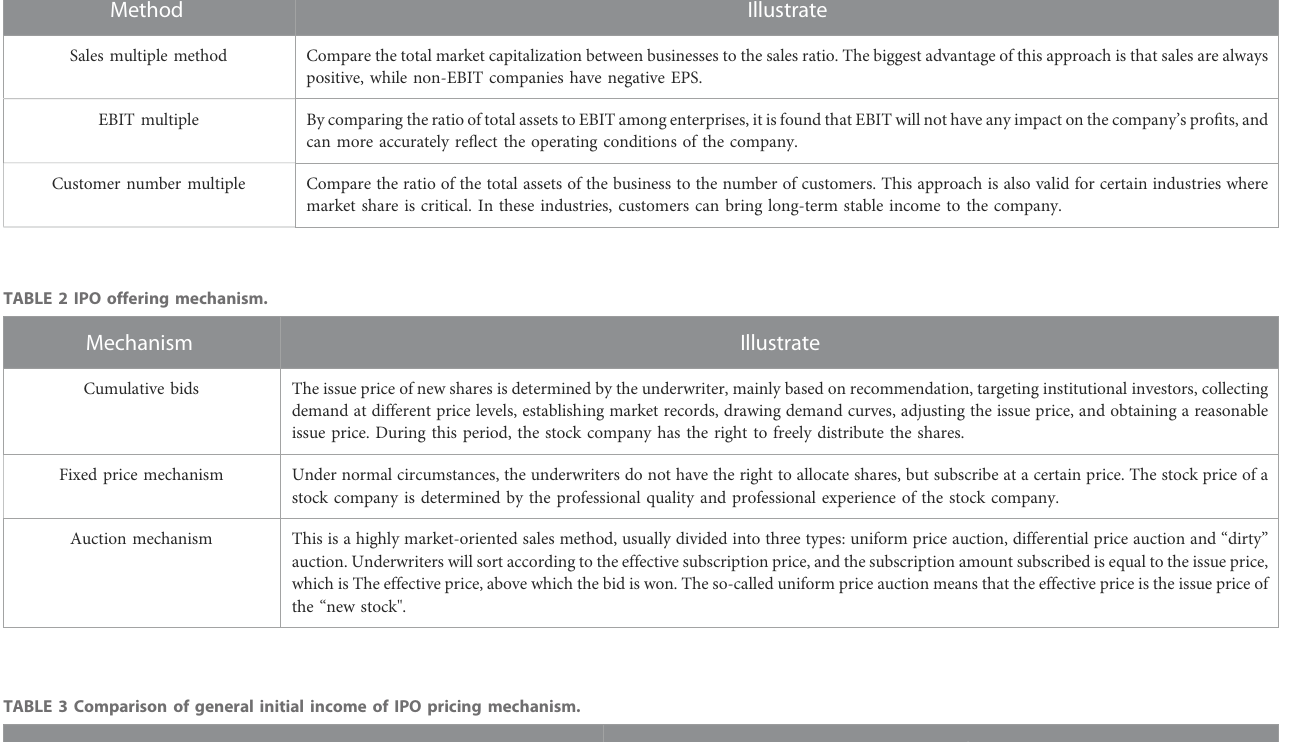
TABLE 1 Commonly used fi nancial data. Method Illustrate Sales multiple method